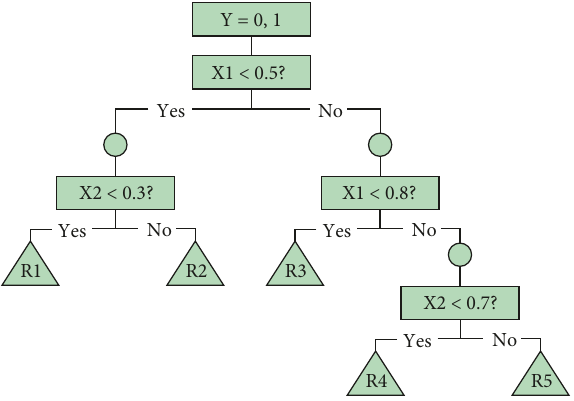
Figure 2: Sample decision trees based on binary target variable